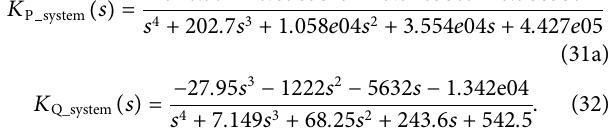
FIGURE 25 | Rotor speeds of G6 with different